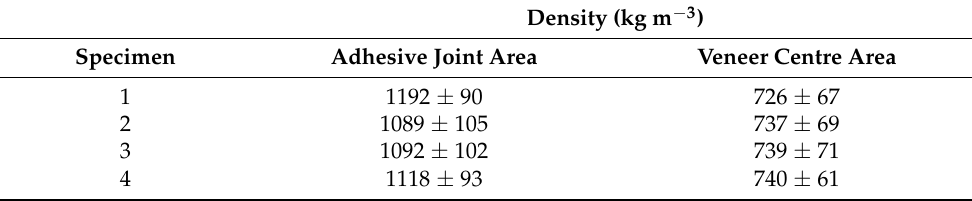
Table 1. Average densities for areas of the adhesive joints and the veneer